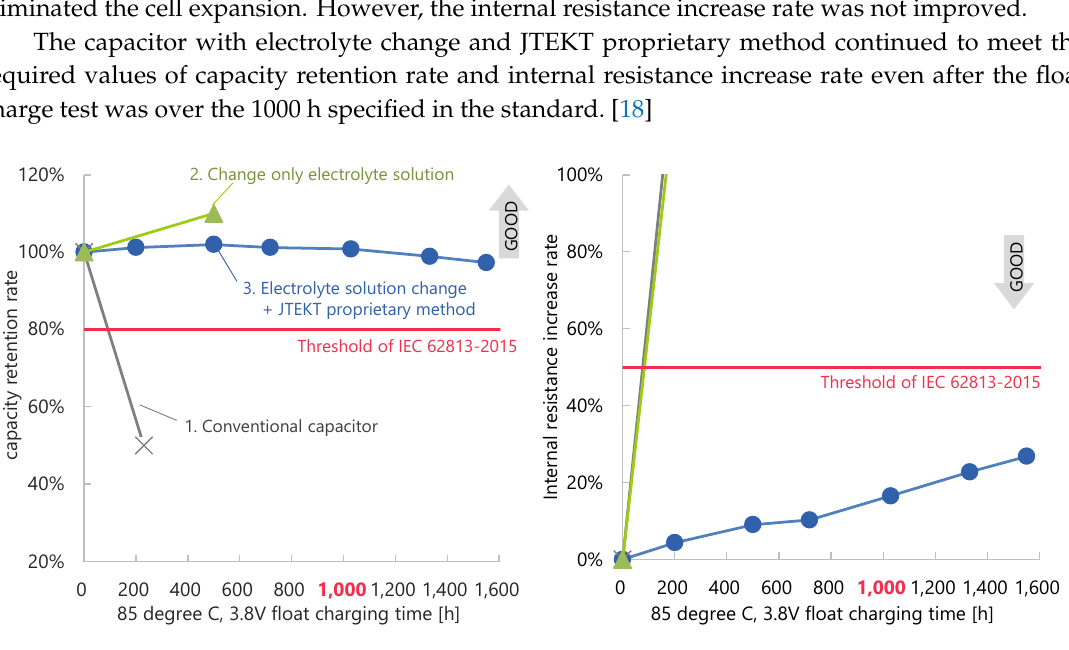
Figure 11. Test result of float charging at 85 °C (according to IEC-62813-2015).